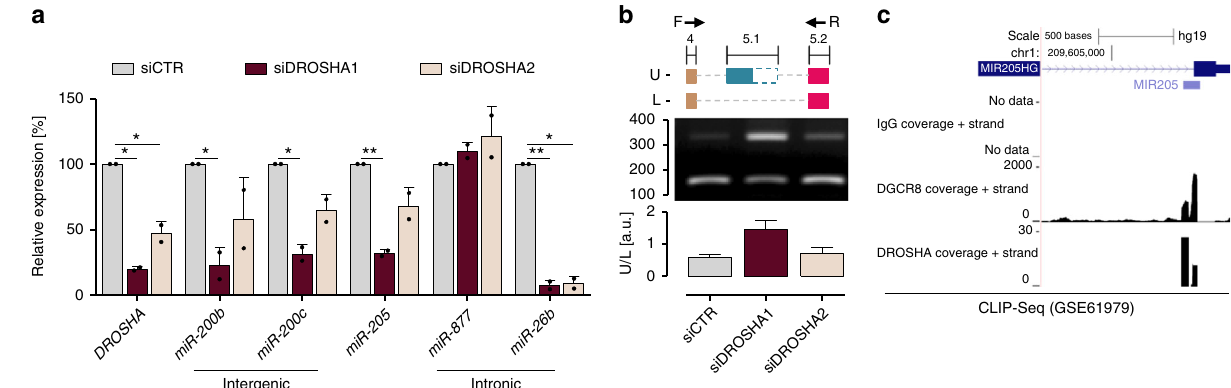
Fig. 3 miR-205 biogenesis is Drosha-dependent. a qRT-PCR showing expression levels of DROSHA mRNA, mature miR-205 and other intergenic/intronic miRNAs upon Drosha silencing in RWPE-1 cells by two siRNAs. Mean + s.d. ( n = 2) plotted. b End-point RT-PCR showing differential splicing of terminal exons of LEADR primary transcript upon Drosha silencing ( top ). Used primers (F on ex-4 and R on ex-5.2) are depicted. Ratio between upper (U) and lower (L) band reported in the bar plot ( bottom ). c RNA-Seq peaks of Drosha and DGCR8 occupancy on LEADR / MIR205HG primary transcript, as from CLIP experiments (GSE61979). IgG peaks reported as negative control. For comparison, CLIP data for miR-26b and miR-877 are shown in Supplementary Fig. 3h. ∗ p < 0.05; ∗∗ p < 0.01 (Student ’ s t test). Source data are provided as a Source Data fi le, together with n of all experiments